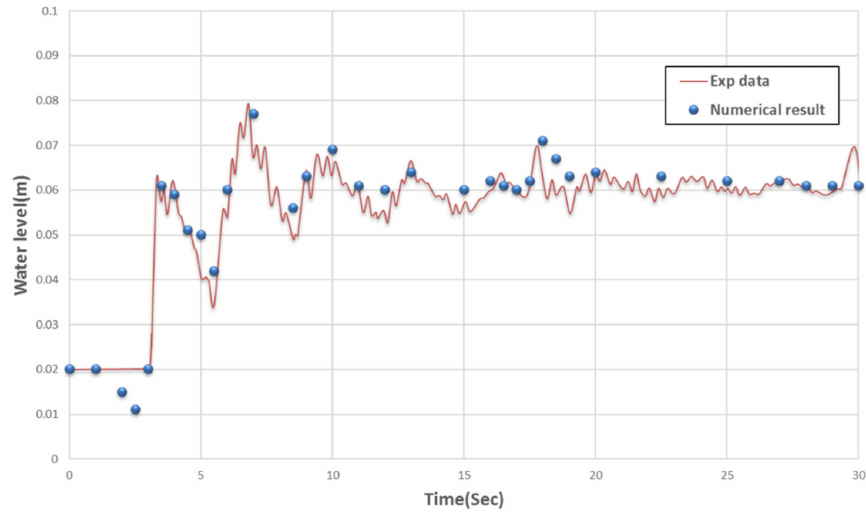
Figure 6. Water level variations at the station of G 1 during the 30 s after dam break.